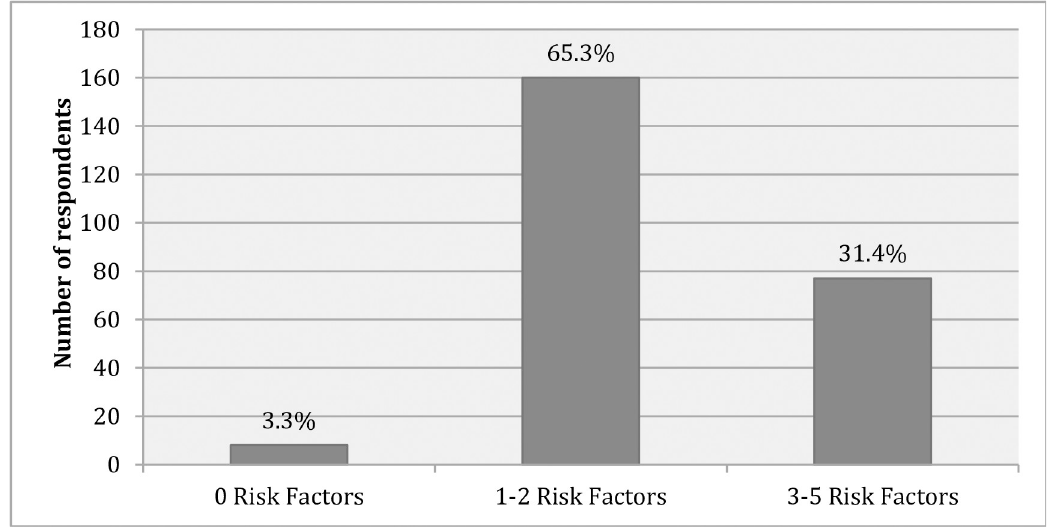
Fig 2. Combined risk factors among the adult population in Kathmandu (n =